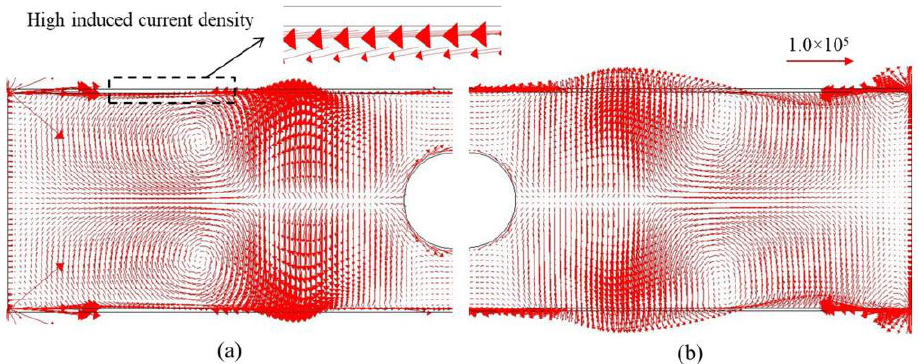
Figure 12. Vectors of time-averaged induced electrical current on plane 1 ( a ) EMBr with electrically-insulated walls; ( b ) EMBr with electrically-conducting walls.